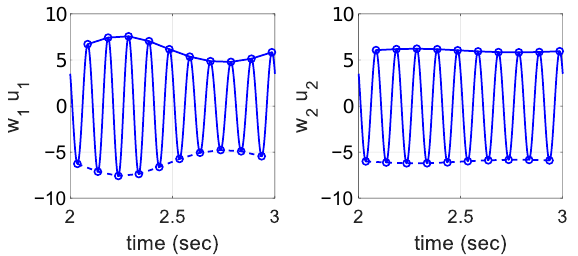
Figure 11. Modulated control signals for the zero output fault mode.